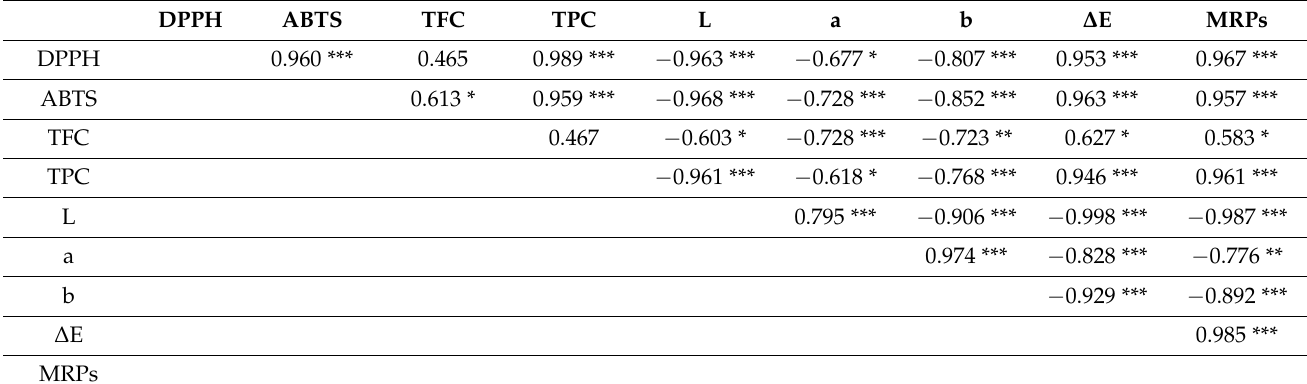
Table 2. Pearson correlations between physicochemical properties of puffed CWPG.